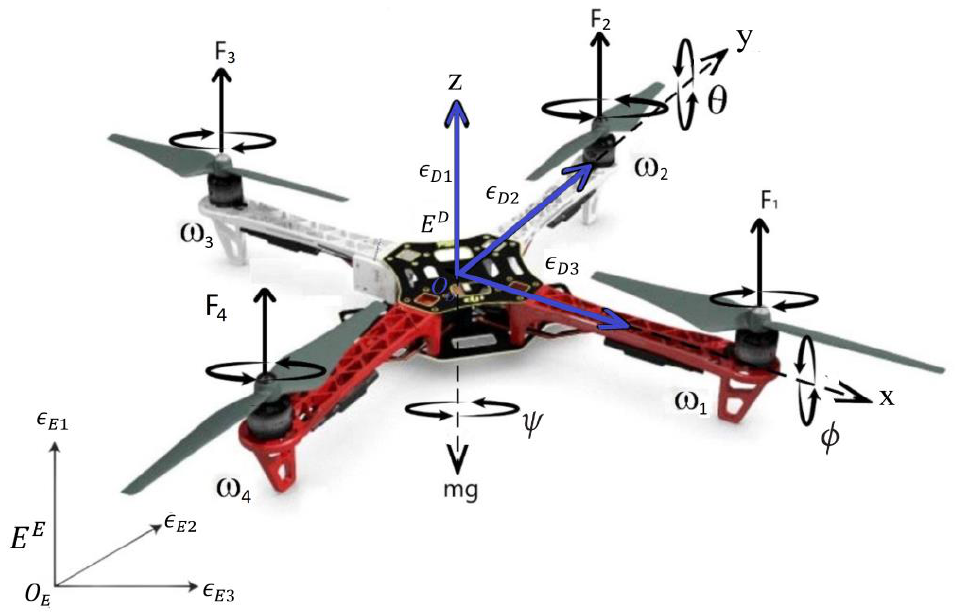
Figure 5. Frameworks used for quadcopter orientation.